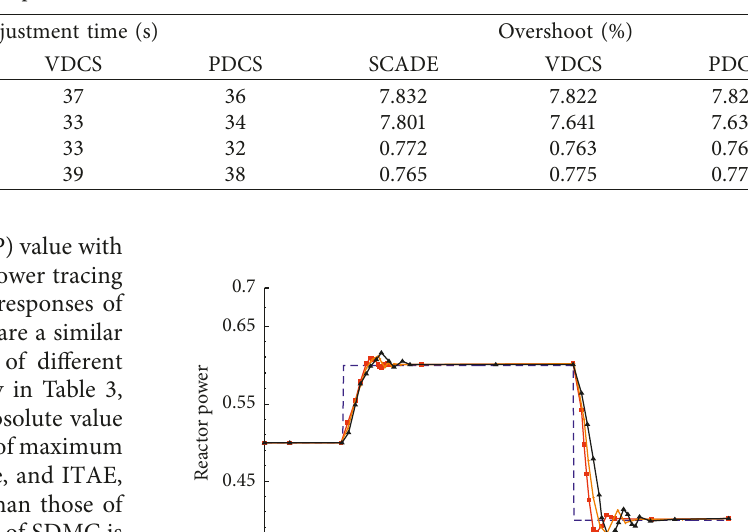
Figure 9: Verification results on different conditions. (a) Start-up of reactor. (b) Lifting and reducing of load. (c) Fluctuation of load in wide range. (d) Load shedding. Table 2: Comparison of different verification methods.